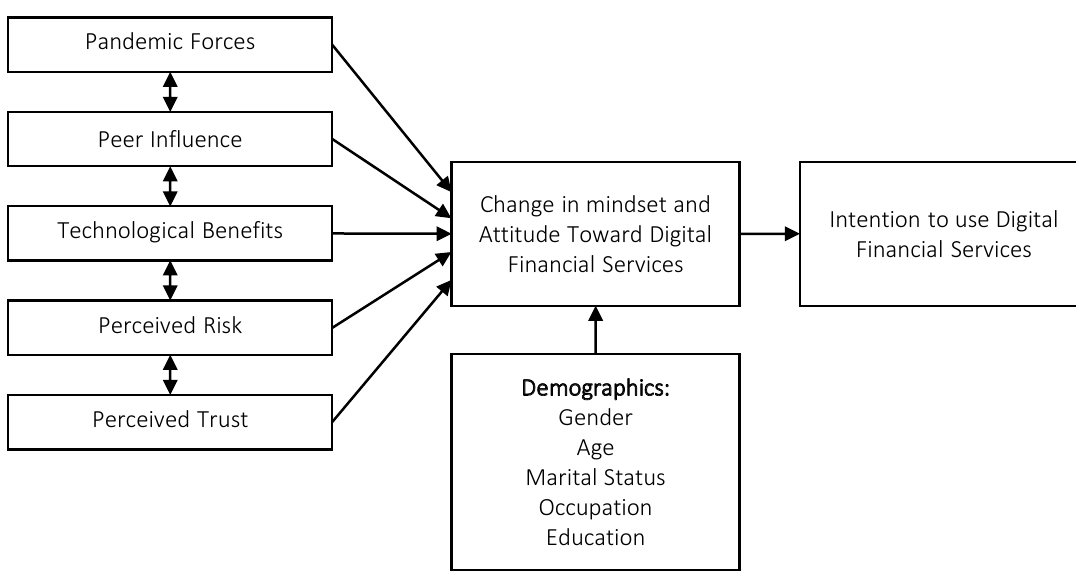
Figure 1. Factors changing adult’s mindset and attitudes towards the intention to use digital financial